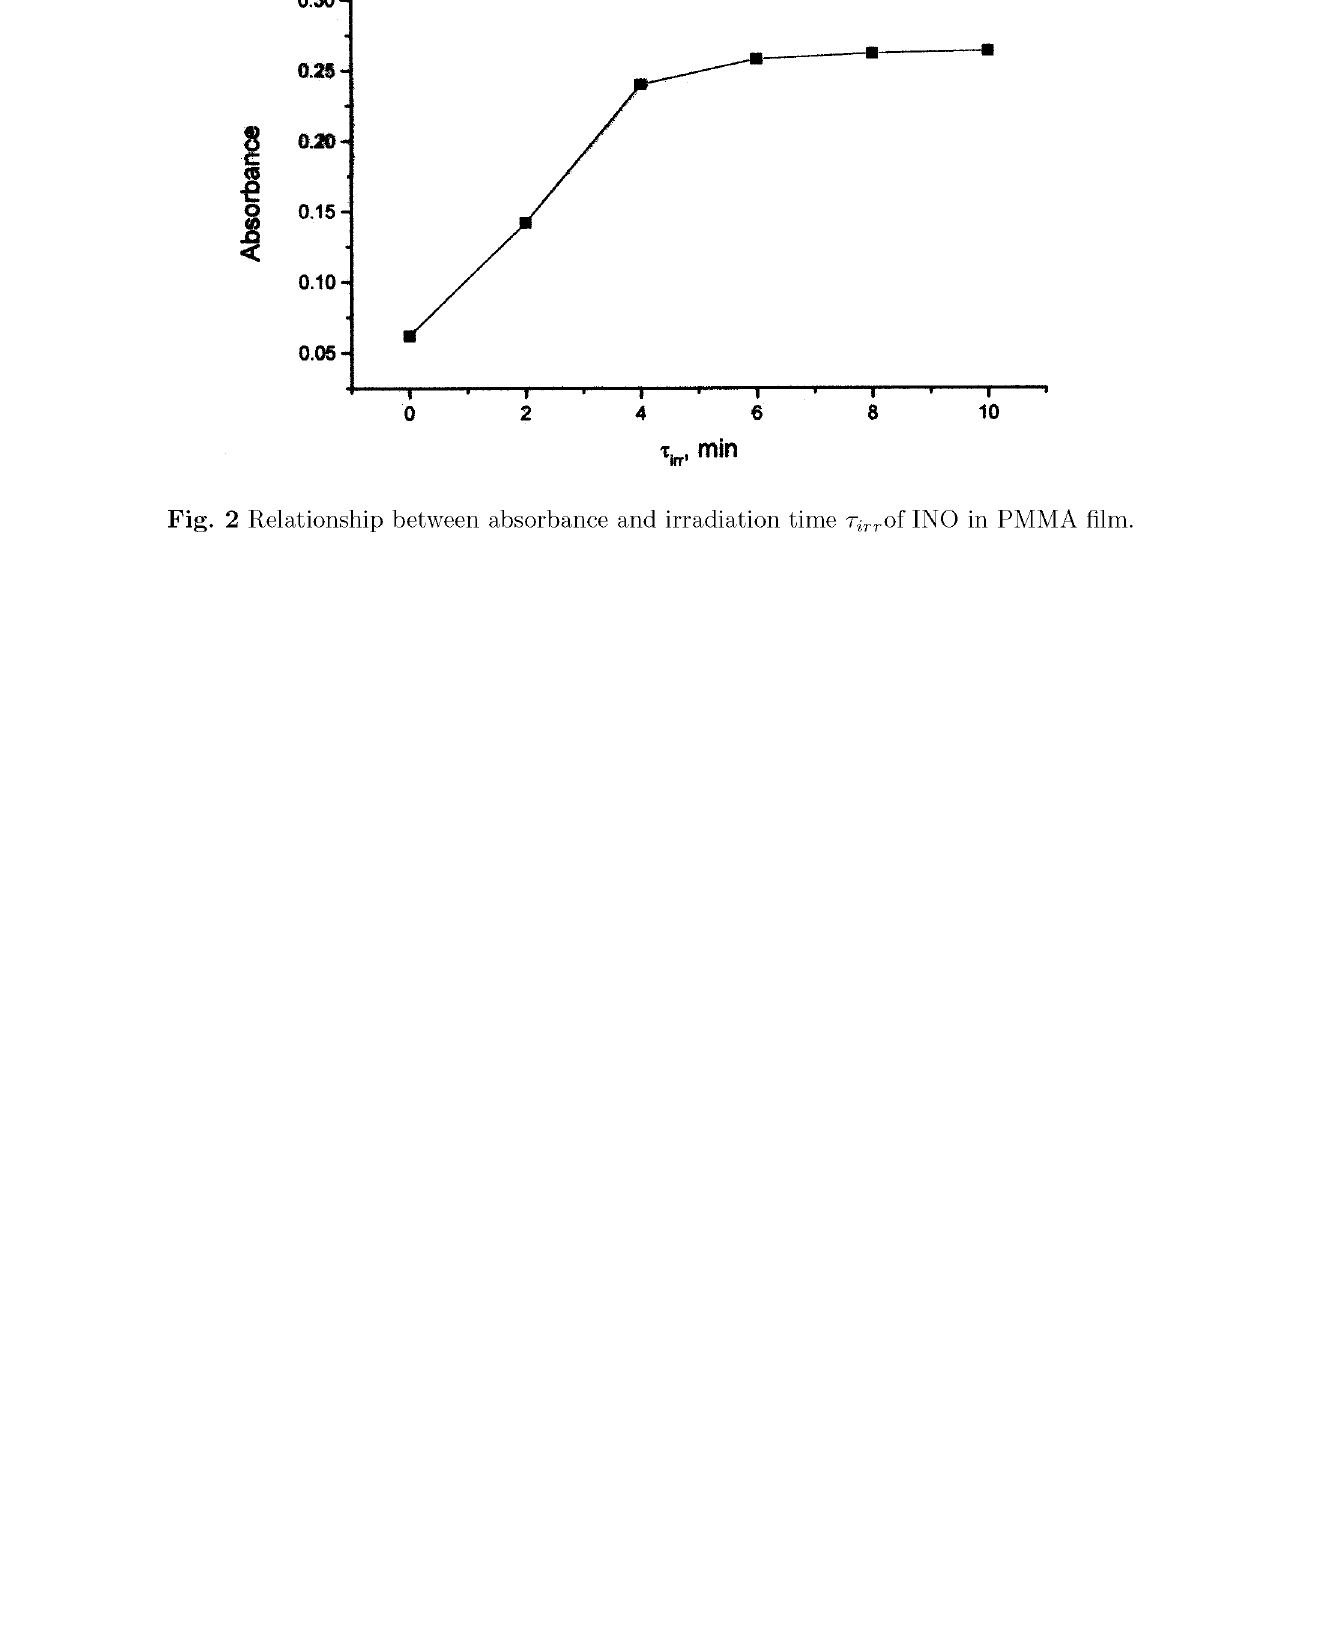
Fig. 2 Relationship between absorbance and irradiation time r,~of INO in PMMA